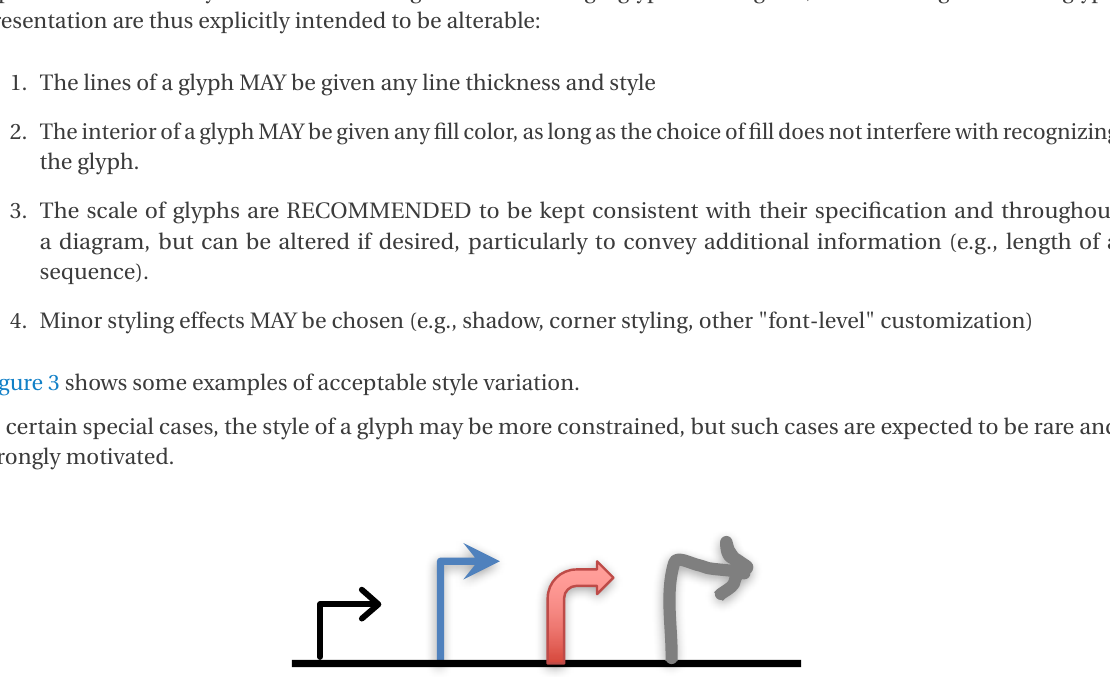
Figure 3: Examples of acceptable style variation for a Promoter